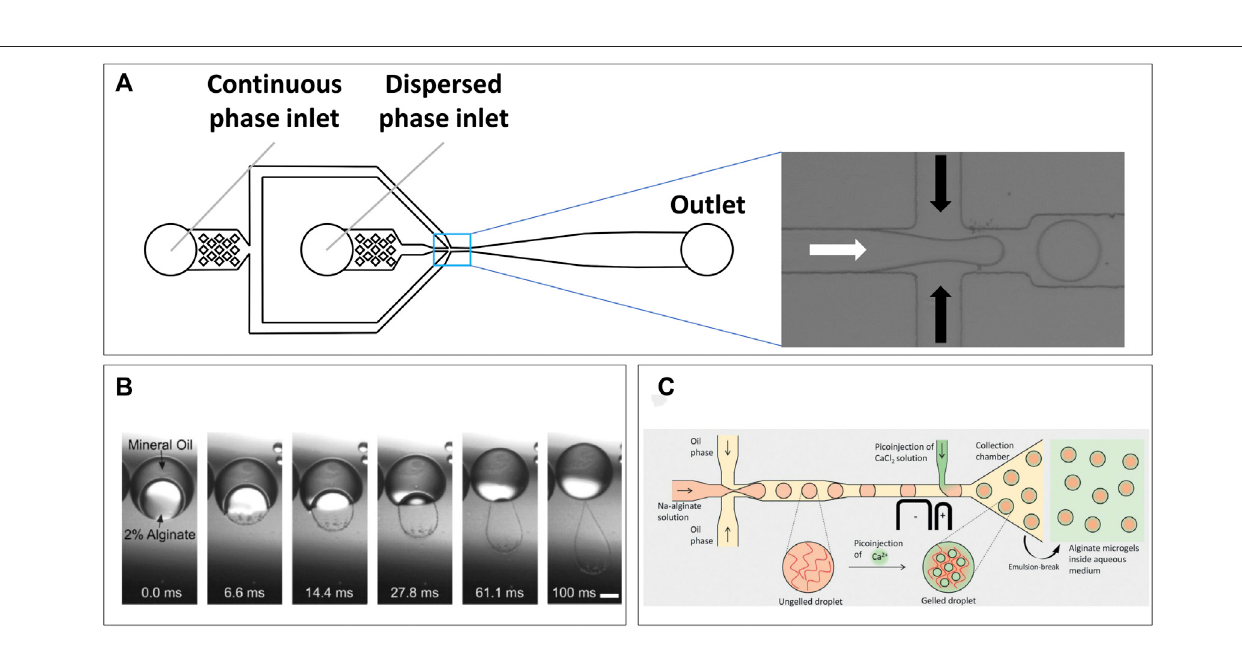
Frontiers in Bioengineering and Biotechnology |